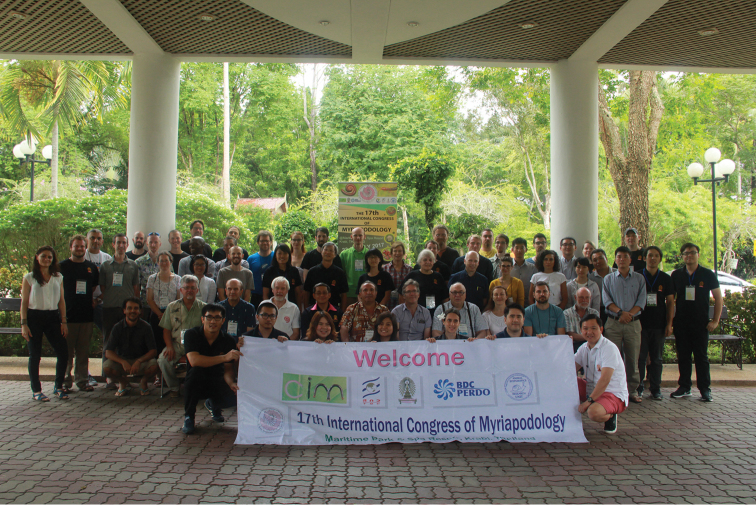
 Group photo of the 17th International Congress of Myriapodology.